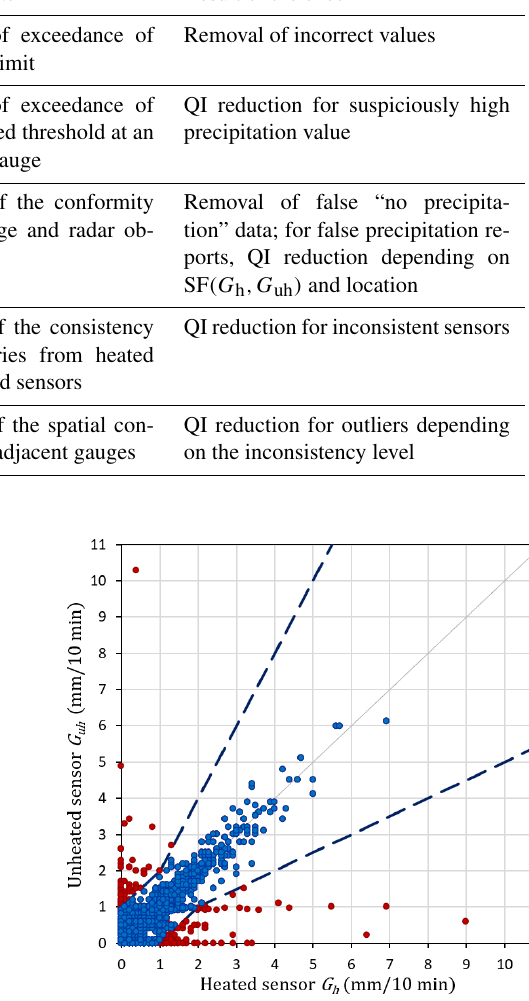
Figure 3. Precipitation data from G uh and G h sensors that are sim- ilar (blue) and not similar (brown). The similarity of the measure- ments from all rain stations on 22 May 2019 was determined using the similarity function (SF). The two dashed lines delimit the area in which the measurements are considered